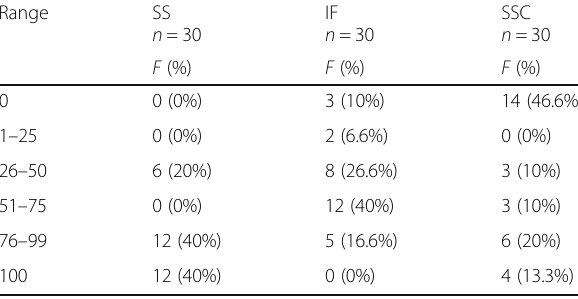
Table 3 Frequency distribution of RCTs depending on the percentage of thickness affection